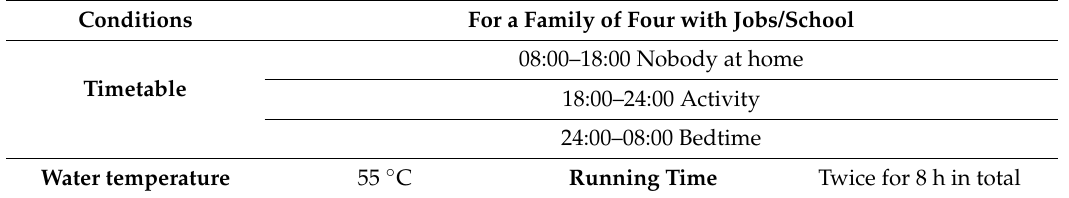
Table 4. Hot water boiler operation outline.